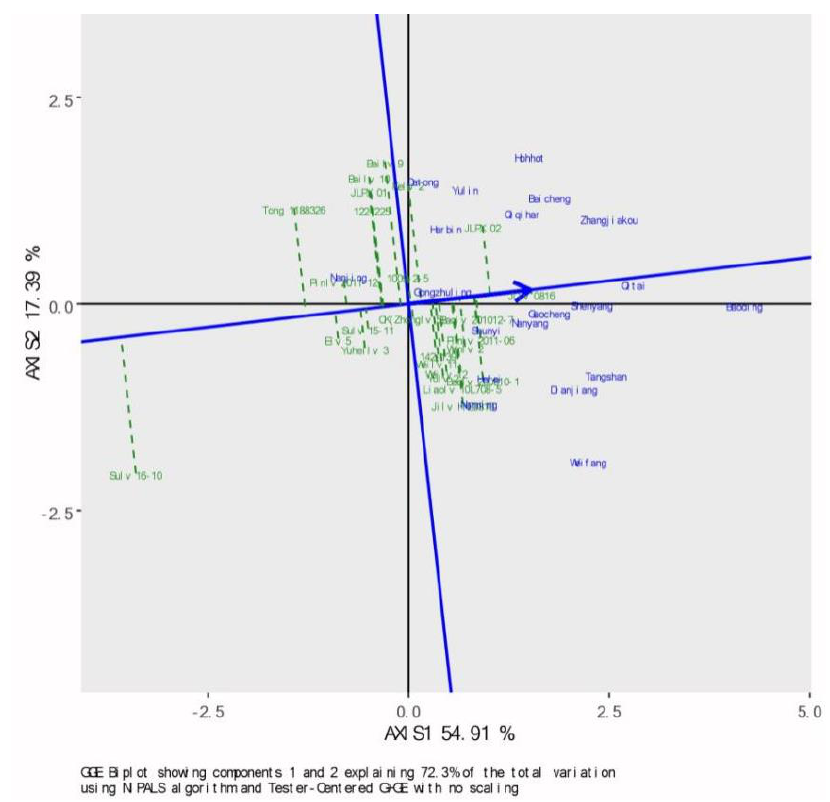
Figure 4. Analysis of yield and stability of 25 varieties in 20 sites.